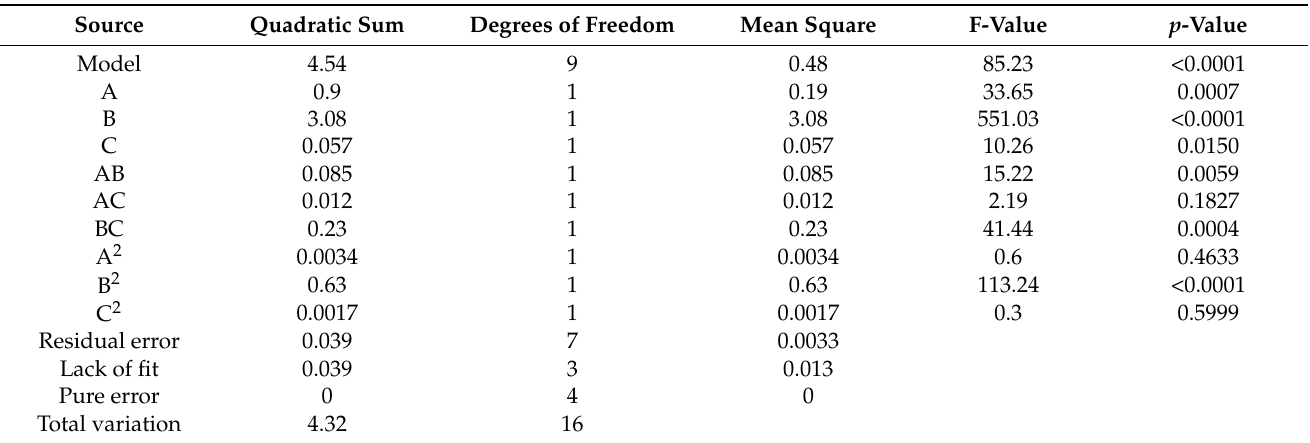
Table 4. Analysis of the variance of ∆ T.